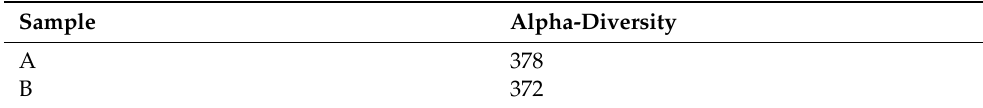
Table 4. Alpha diversity of samples.